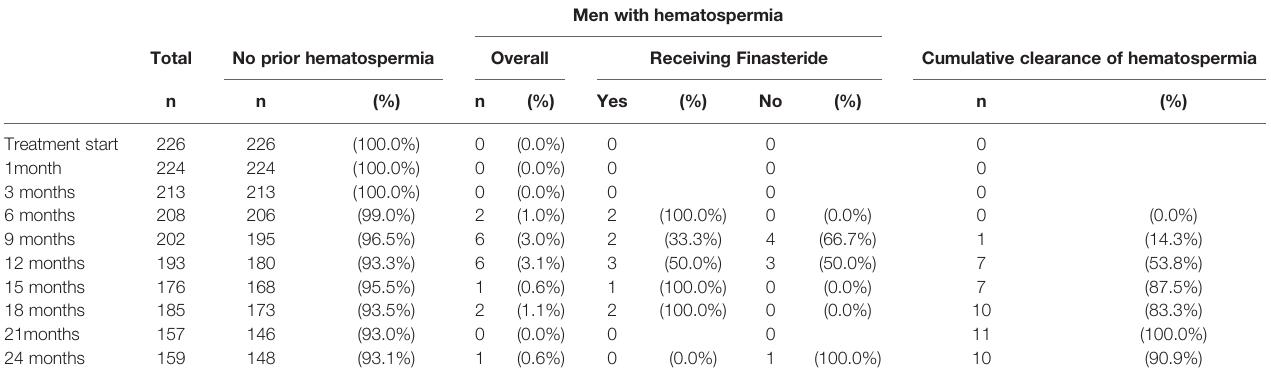
TABLE 2 | Hematospermia Incidence after